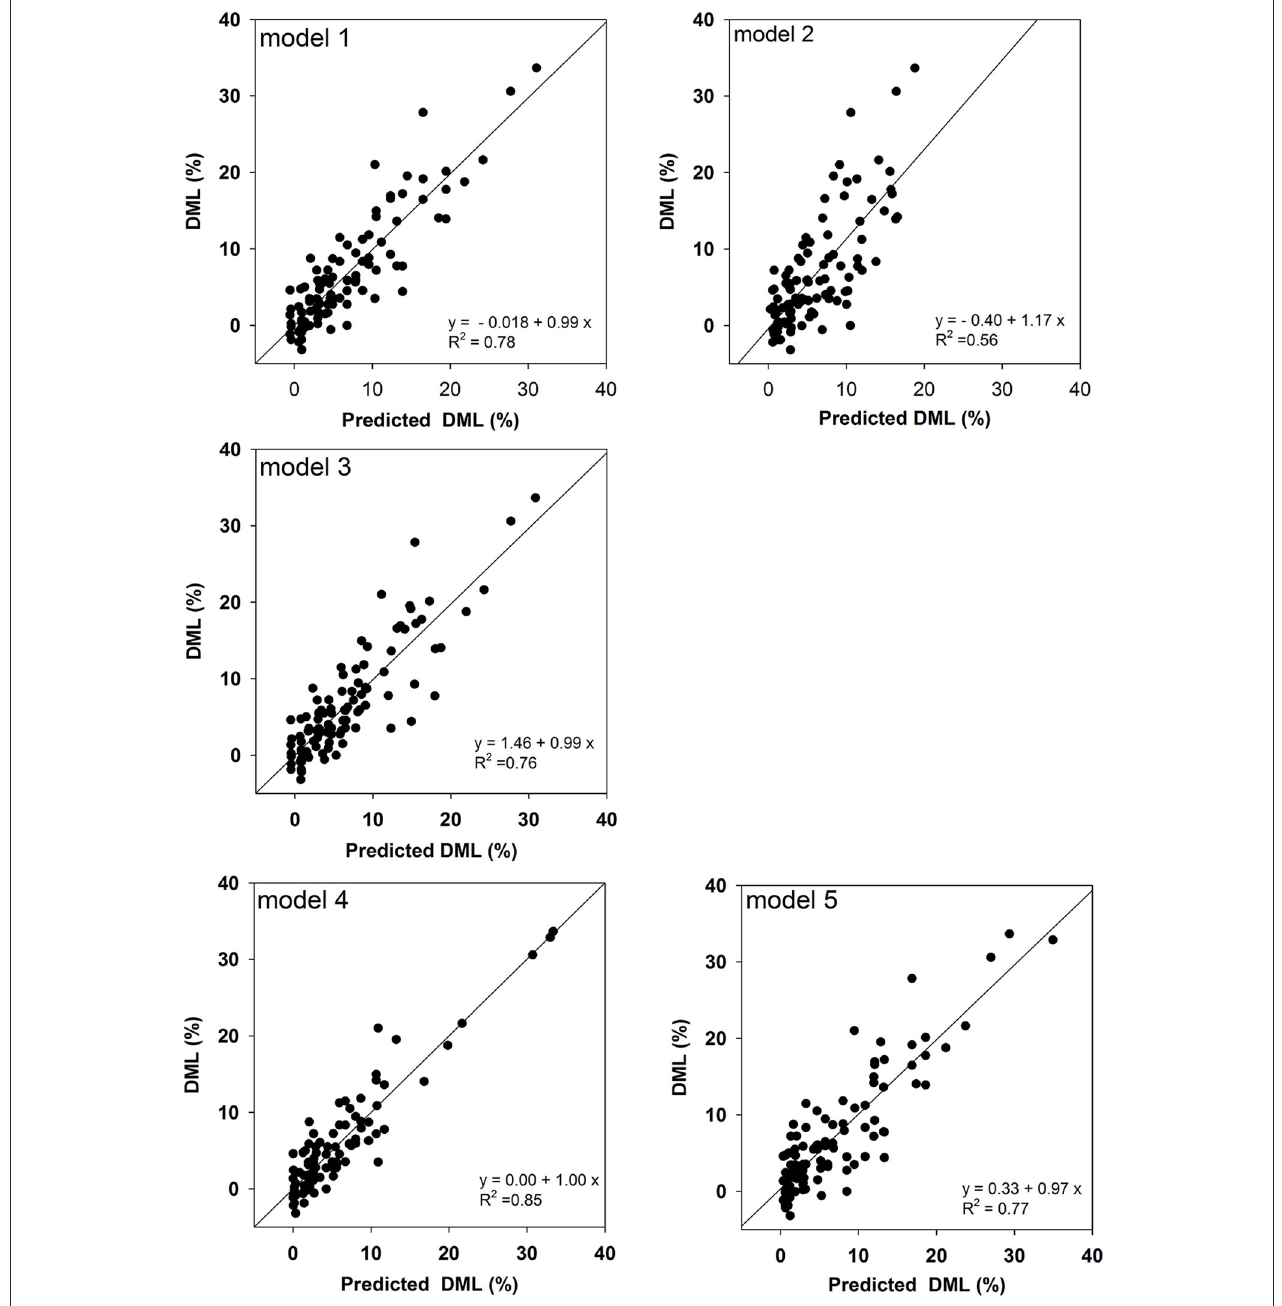
FIGURE 5 | Scatter plots and regression lines between dry matter loss (DML) and predicted DML from linear models 1, 2, and 3 and non-linear models 4 and 5 for willow chips stored in the shell and core of outdoor piles at different time of the